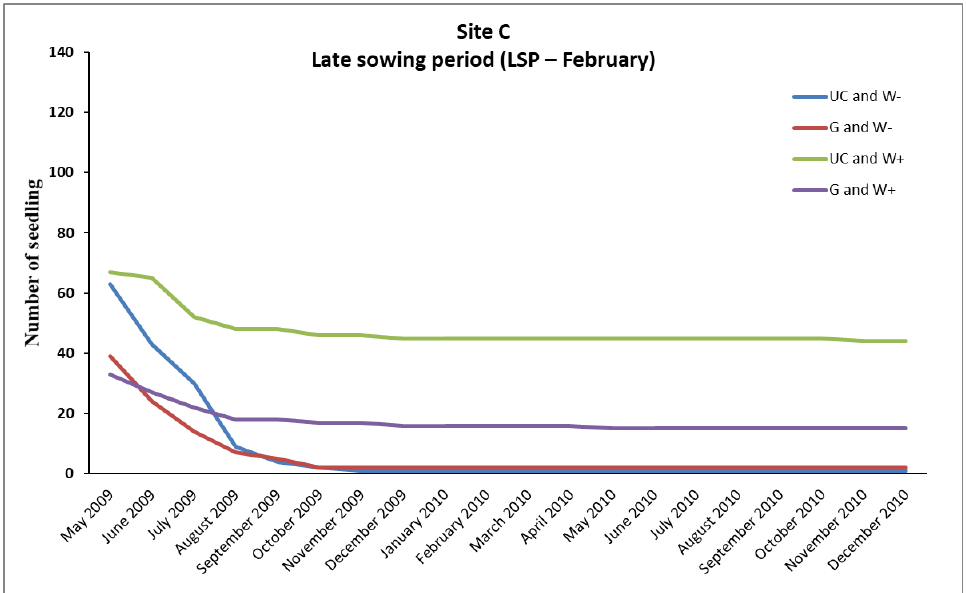
Figure 4. Monthly seedling survival (number of living seedlings) of the February sowing (LSP) in the plots of each combination of the two factor levels in site C for the period May 2009–December 2010 (the May 2009 record shows the number of germinated seeds).